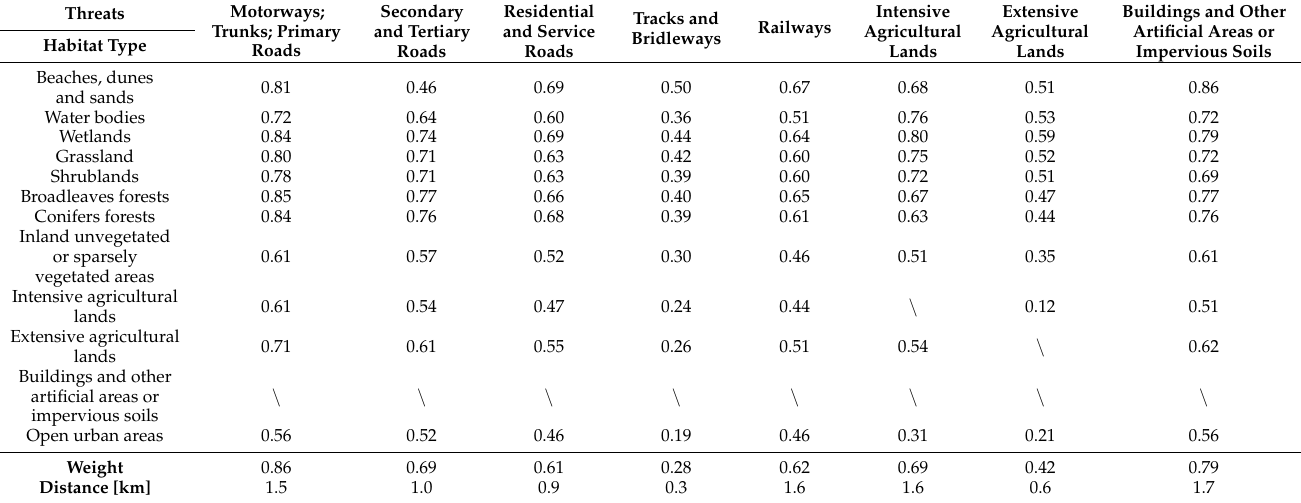
Table 2. Input values regarding the threats parameters generated by the survey: habitat sensitivity to the types of threats, impact (weight) of different threats on each habitat type, and maximum distance at which the threats can affect the habitat (adapted from